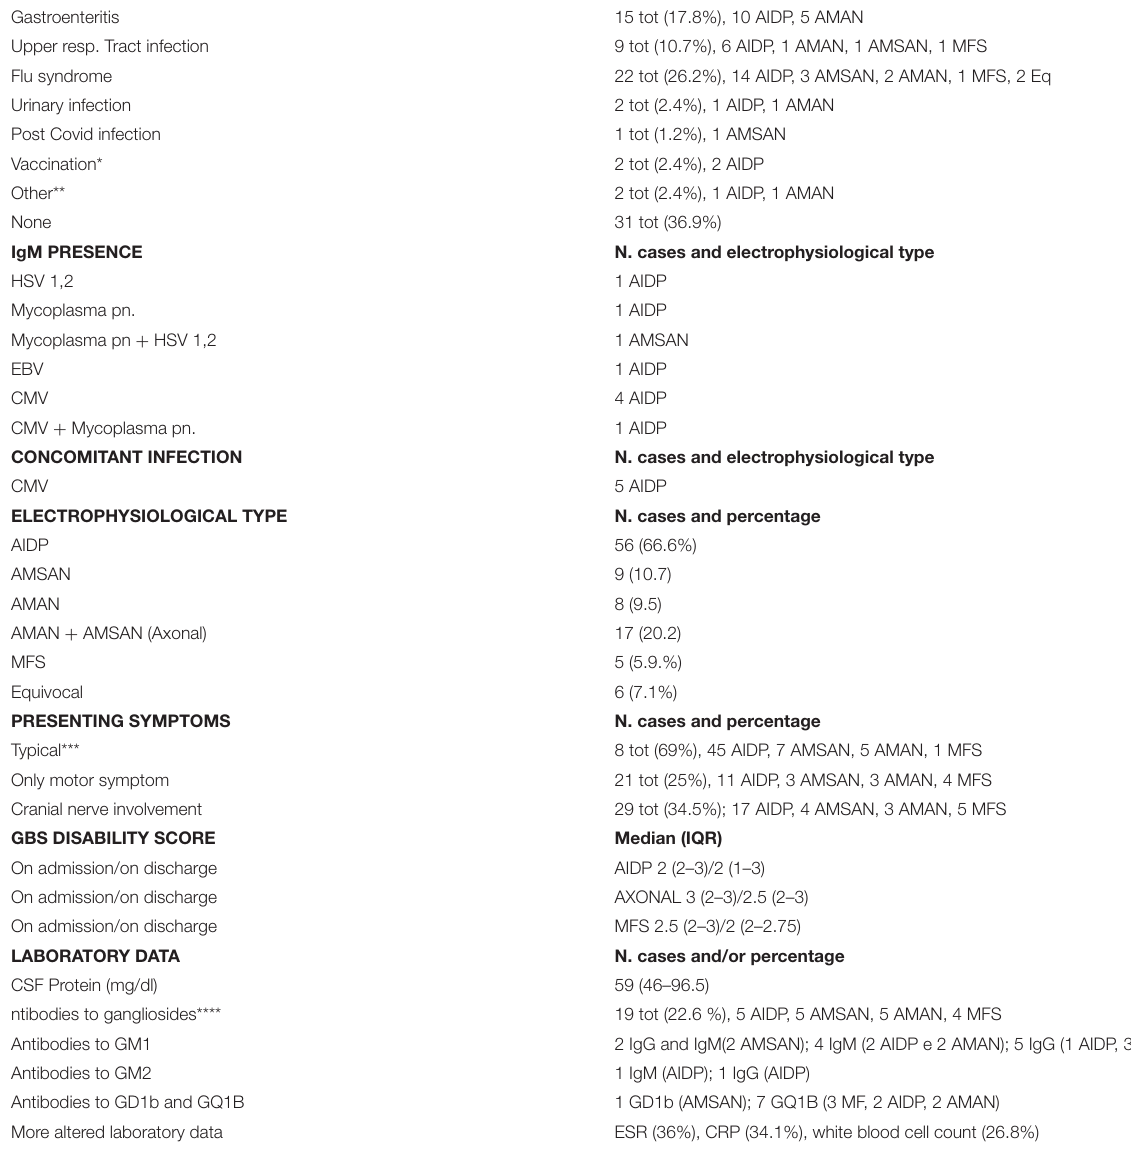
TABLE 1 | Epidemiological, clinical, laboratory, and electrophysiological features of 84 patients with GBS. PRECEDING EVENTS N. cases, percentage and electrophysiological